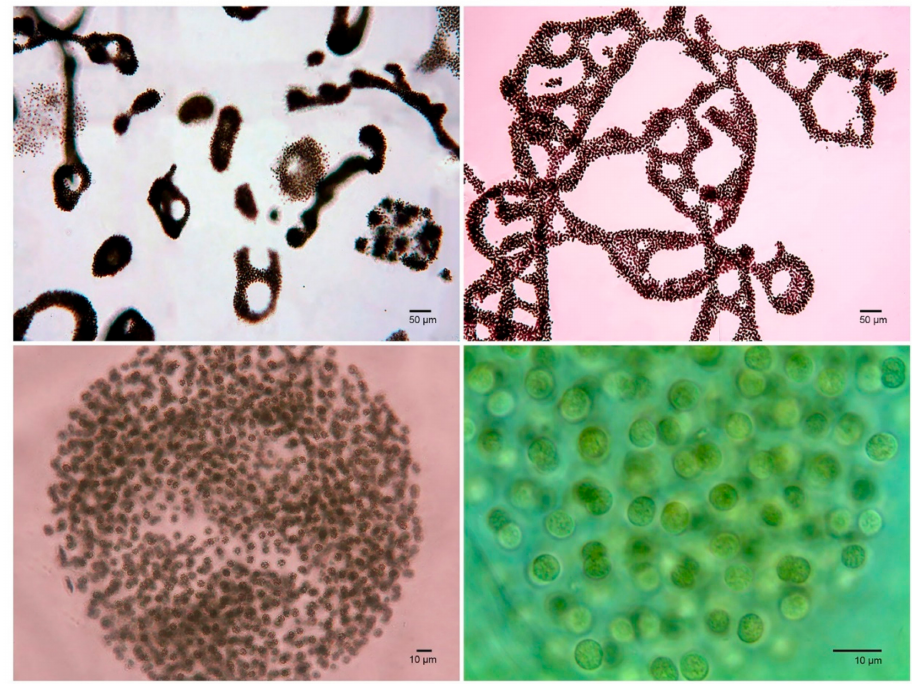
Figure 3. Diversity of colonies of Microcystis aeruginosa from the Santa Mar í a del Oro lake, Nayarit, during the cyanobacteria bloom. Photo credit: G é nesis G. Ochoa